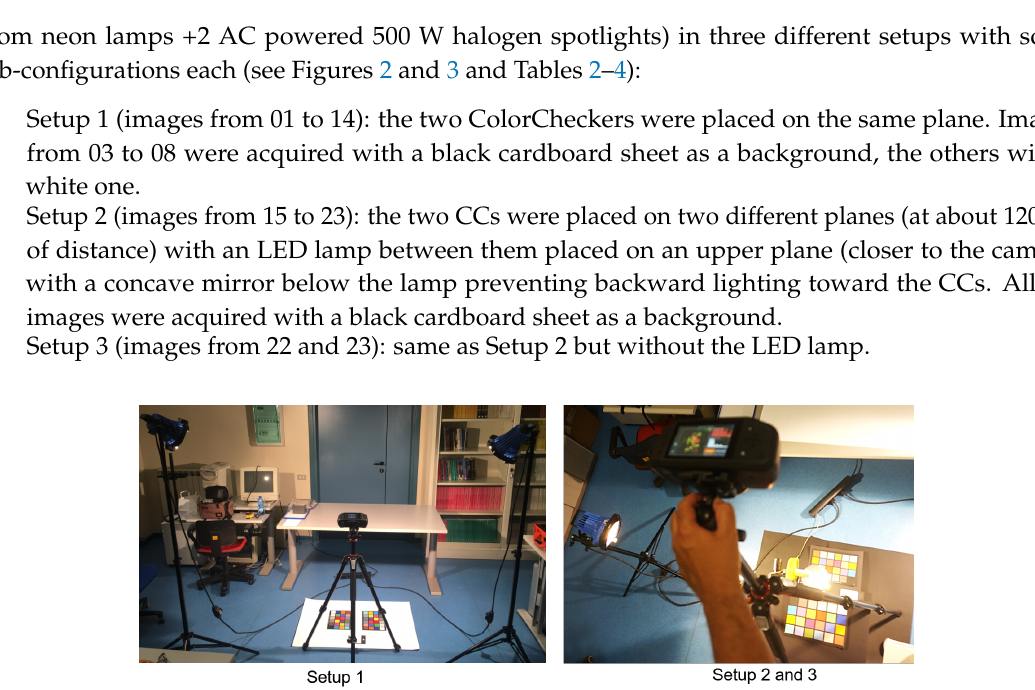
Figure 2. Pictures of the experimental setups.